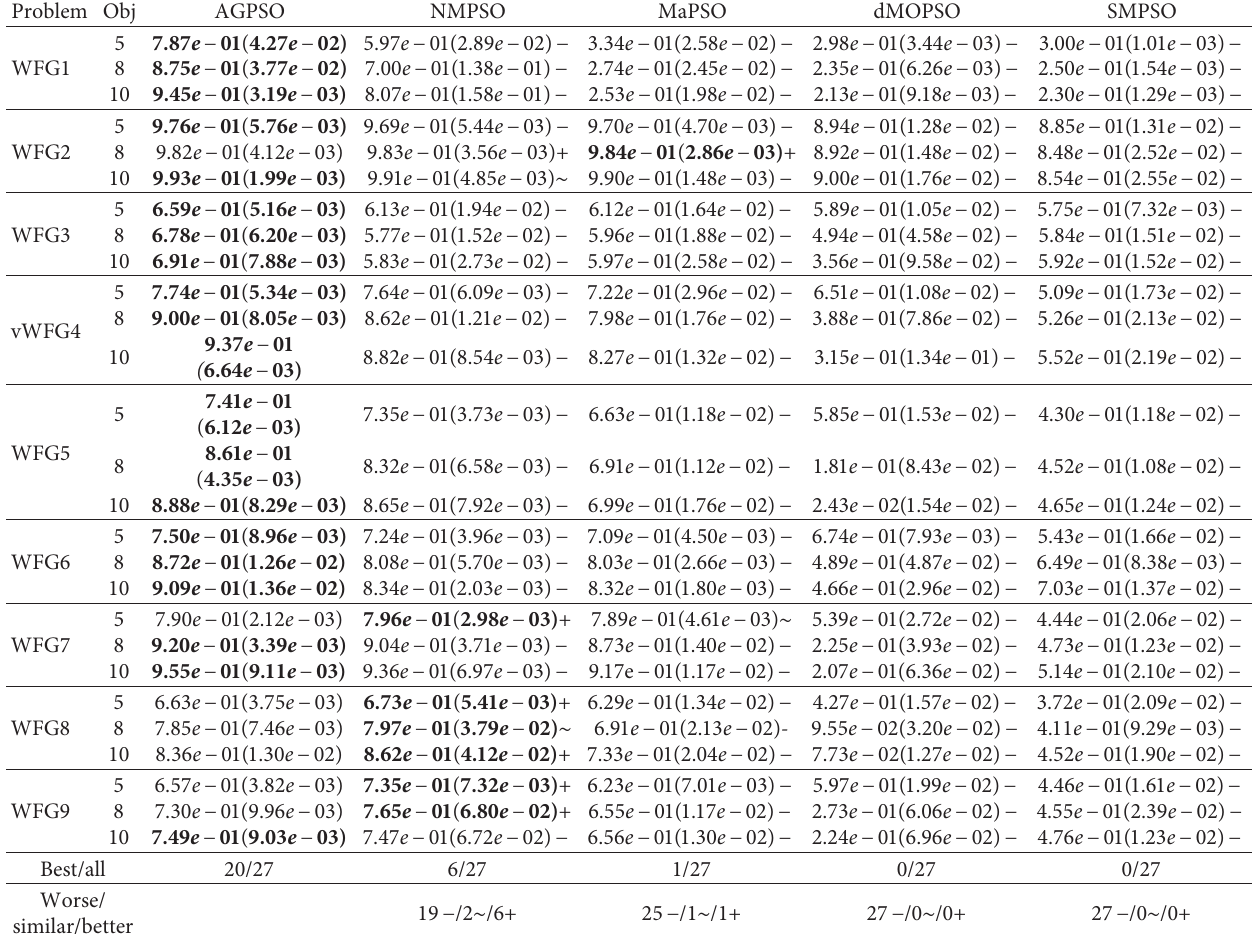
Table 2: Comparison of results of AGPSO and four current MOPSOs on WFG1-WFG9 using HV. Problem